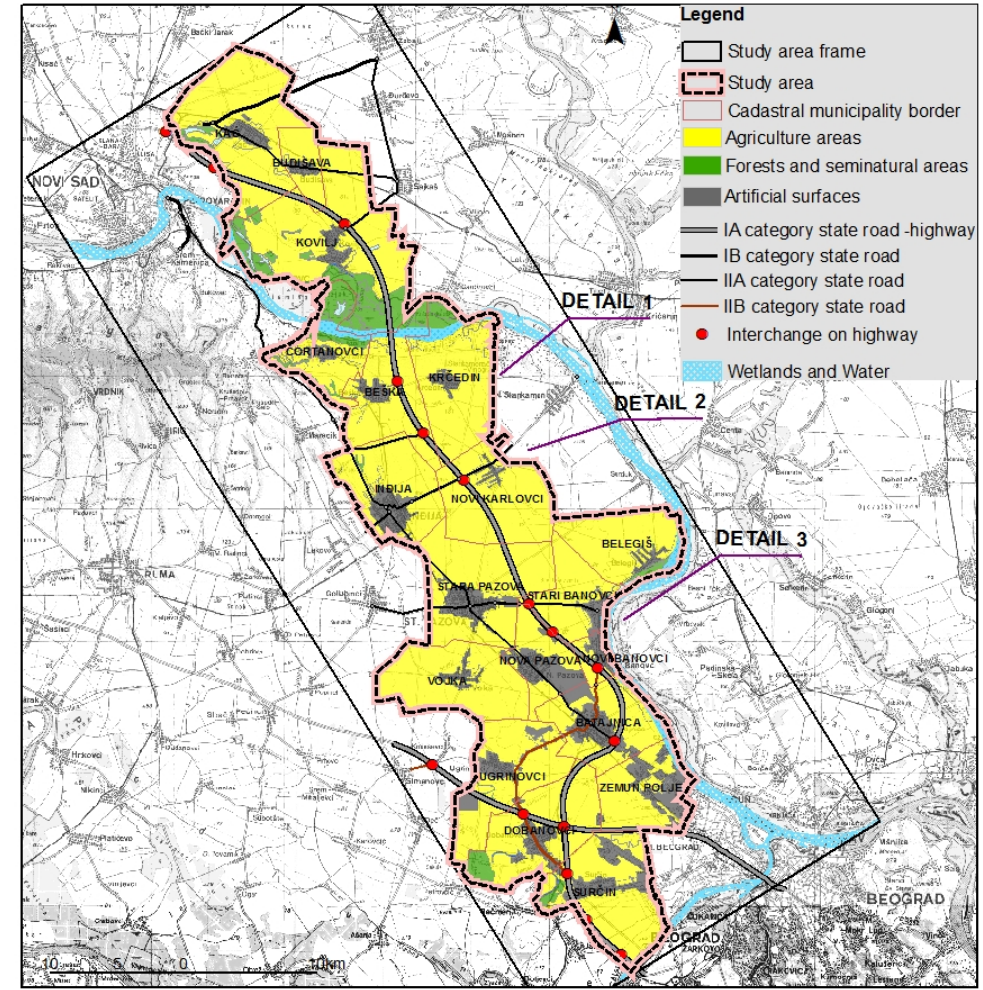
Figure 2. Land use in the study area 2018 (authors’ elaboration on the basis of CLC 2018 database, UA 2018 database [39] and National Spatial Data Infrastructure GeoSrbija [42]).